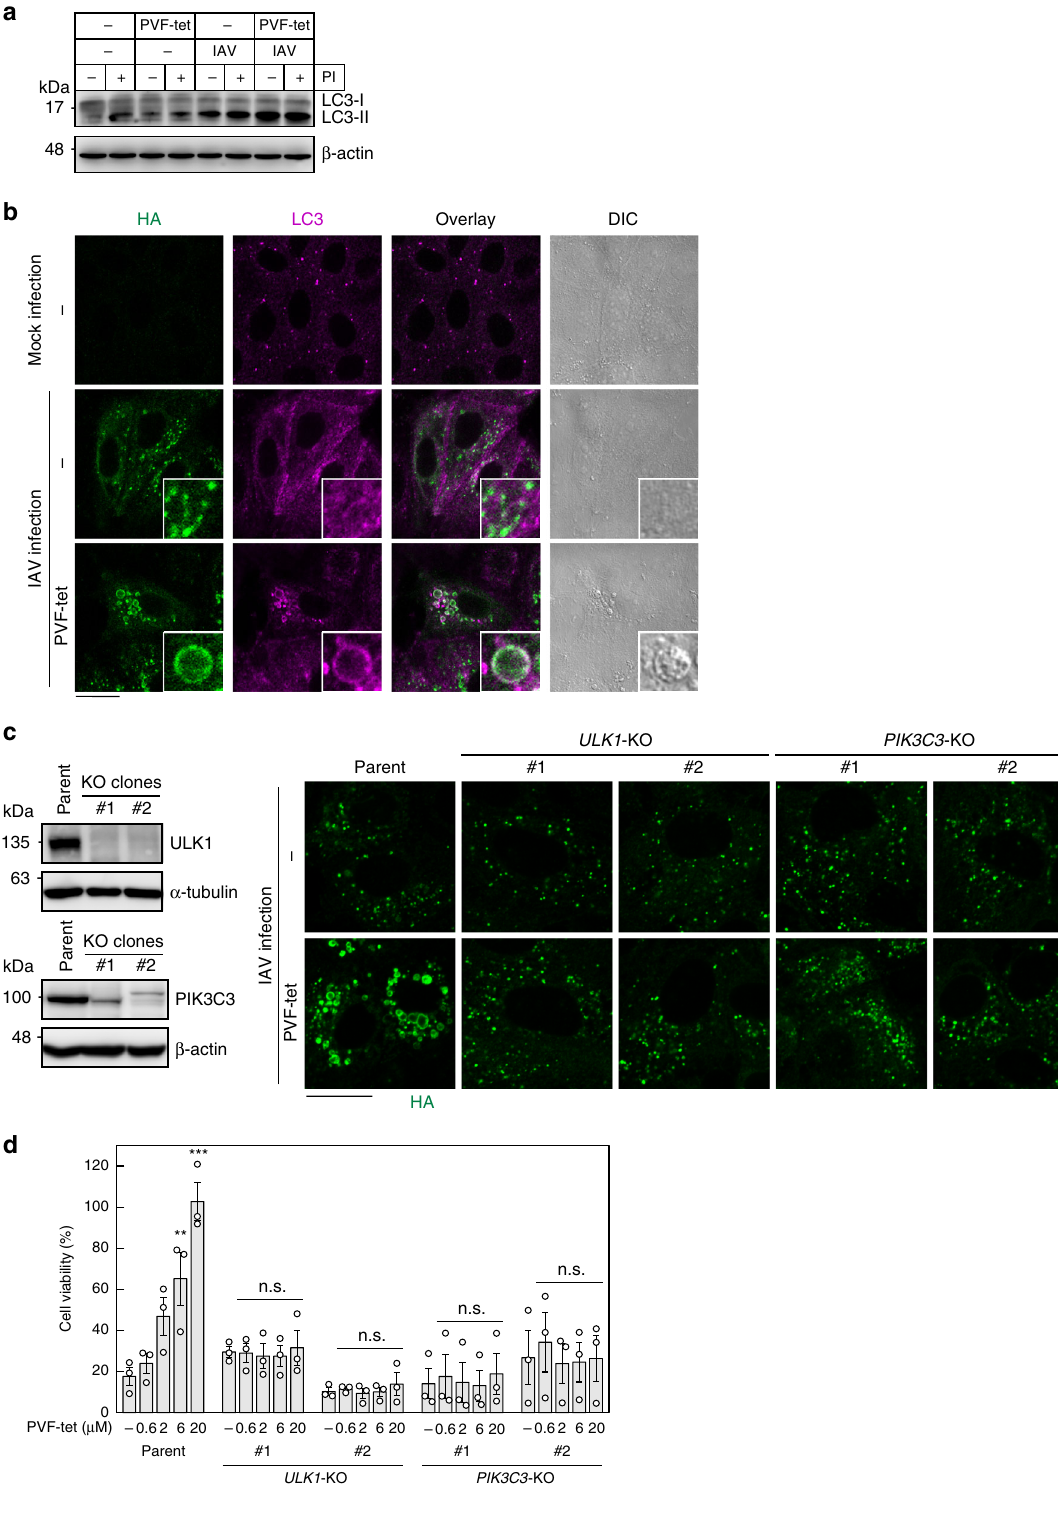
Figs. 17b and 17c), con fi rming that (D)PVF-tet facilitates